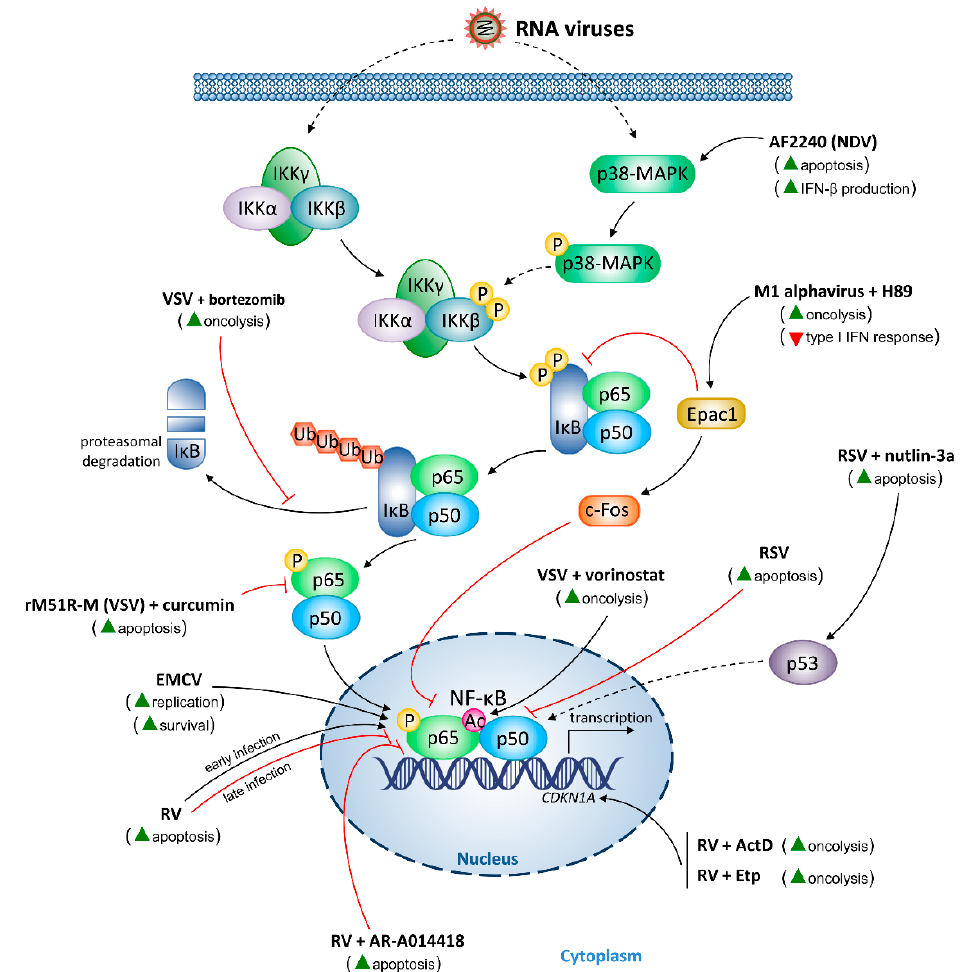
Figure 3. Modulation of nuclear factor (NF)- κ B signaling by oncolytic RNA viruses. Pointing black arrows indicate activation of NF- κ B signaling components, whereas red blunt arrows indicate NF- κ B inhibition. The effects of therapeutic agents on NF- κ B are shown in the brackets. Green triangles represent induction, whereas inverted red triangles indicate inhibition. Ac, acetyl group; ActD, actinomycin-D; CDKN1A , cyclin-dependent kinase inhibitor 1 gene; c-Fos, cellular oncogene Fos; EMCV, encephalomyocarditis virus; Epac1, exchange protein directly activated by cyclic adenosine monophosphate isoform 1; Etp, etoposide; IFN- β , interferon- β ; IKK α , inhibitor of κ B kinase α ; IKK β , inhibitor of κ B kinase β ; IKK γ , inhibitor of κ B kinase γ ; I κ B, inhibitor of κ B; NDV, Newcastle disease virus; P, phosphate group; p38-MAPK, p38 mitogen-activated protein kinase; RSV, respiratory syncytial virus; RV, reovirus; Ub, ubiquitin moieties; VSV, vesicular stomatitis virus.